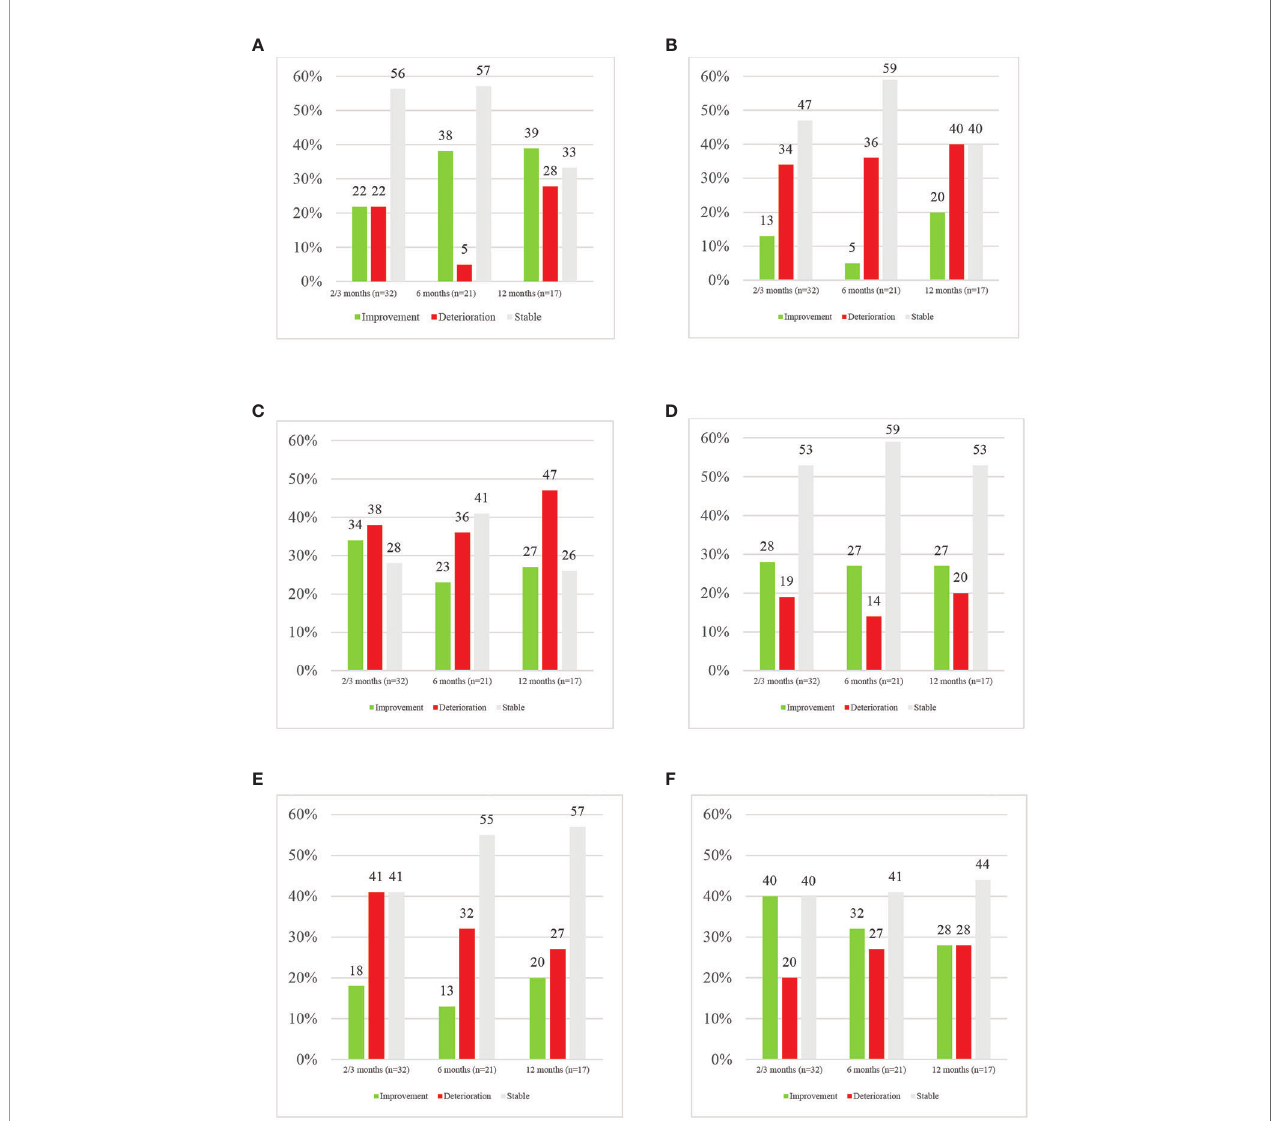
FIGURE 2 | Overview of MCID in HRQoL and its domains per time point. (A) Overview of MCID in overall HRQoL per time point. (B) Overview of MCID in physical functioning per time point. (C) Overview of MCID in role functioning per time point. (D) Overview of MCID in emotional functioning per time point. (E) Overview of MCID in cognitive functioning per time point. (F) Overview of MCID in social functioning per time